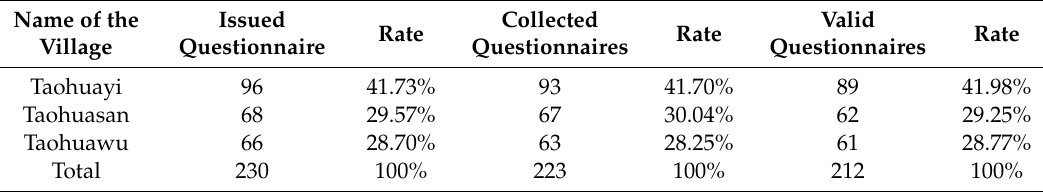
Table 3. Statistical distribution table of